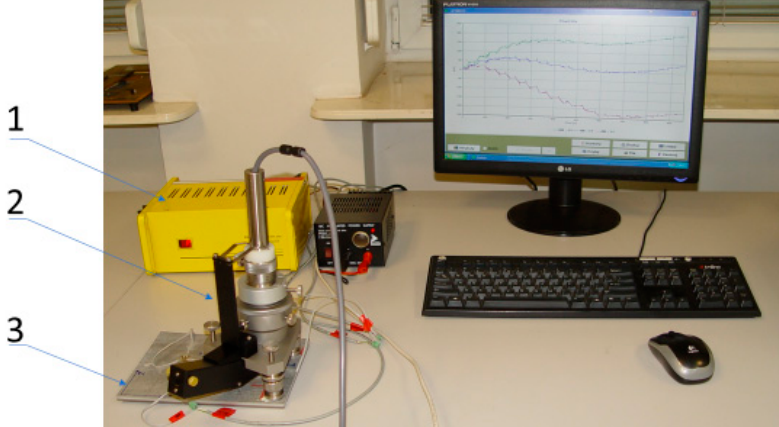
Figure 11. Stand for residual stress measurements: Esam Traveler Plus strain gauge bridge with a power supply (1), RS-200 device (2) and tested material (3).